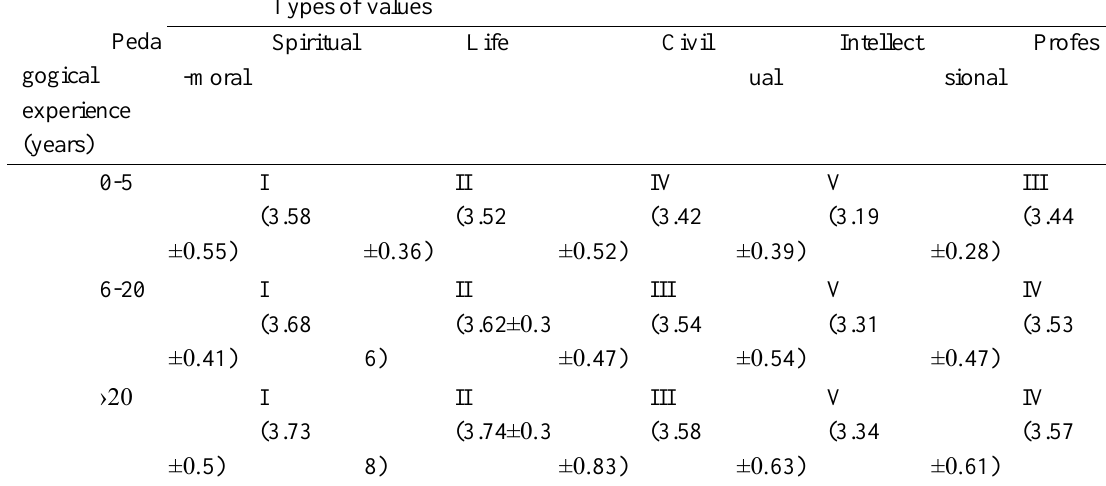
Table 3. Distribution of types of values in Belarusian teachers with different teaching experience (ranks, scores)